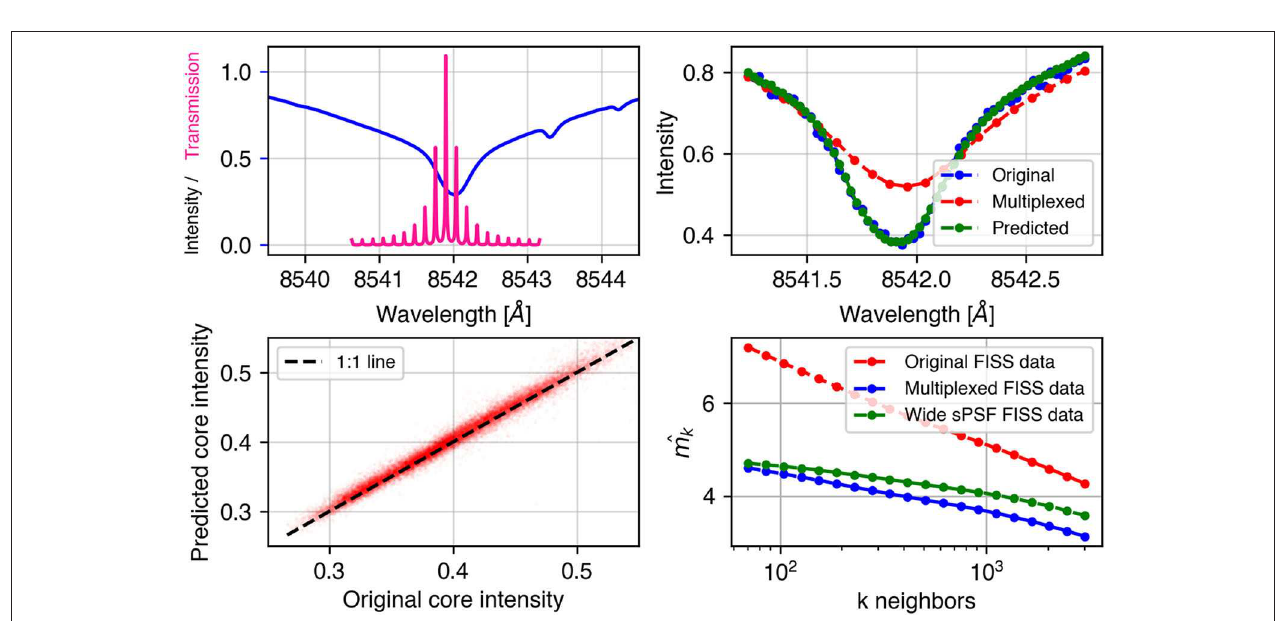
FIGURE 4 | (Top left) The spectral transmission profile is (magenta scaled by 9 for best representation) applied to the spectral profiles overlaid over the average Ca II 8,542 Å line. (Top right) Sample spectral profile from the multiplexing (red), the retrieved spectral profile (green) and the original spectral profile (blue); (Bottom left) Retrieved line core intensity from this approach vs the original line core intensity; (Bottom right) : Maximum Likelihood Intrinsic Dimensionality Estimate for the original FISS data, the multiplexed FISS data and the data convolved with the wide sPSF in section